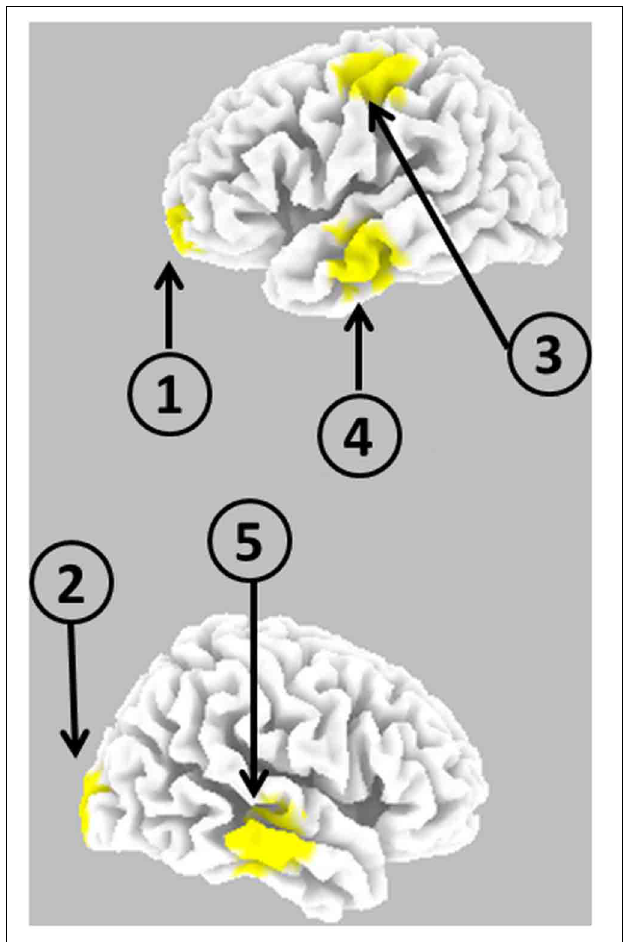
FIGURE 2 | Schematic representation of the anatomical locations of five cortical point sources used for generating EEG.